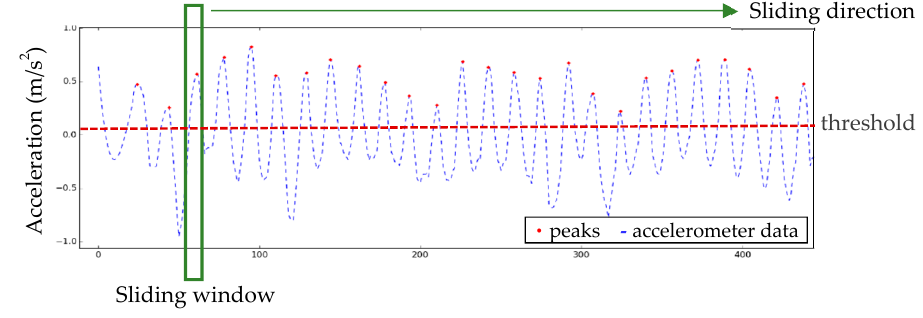
Figure 4. Diagram of peak detection .